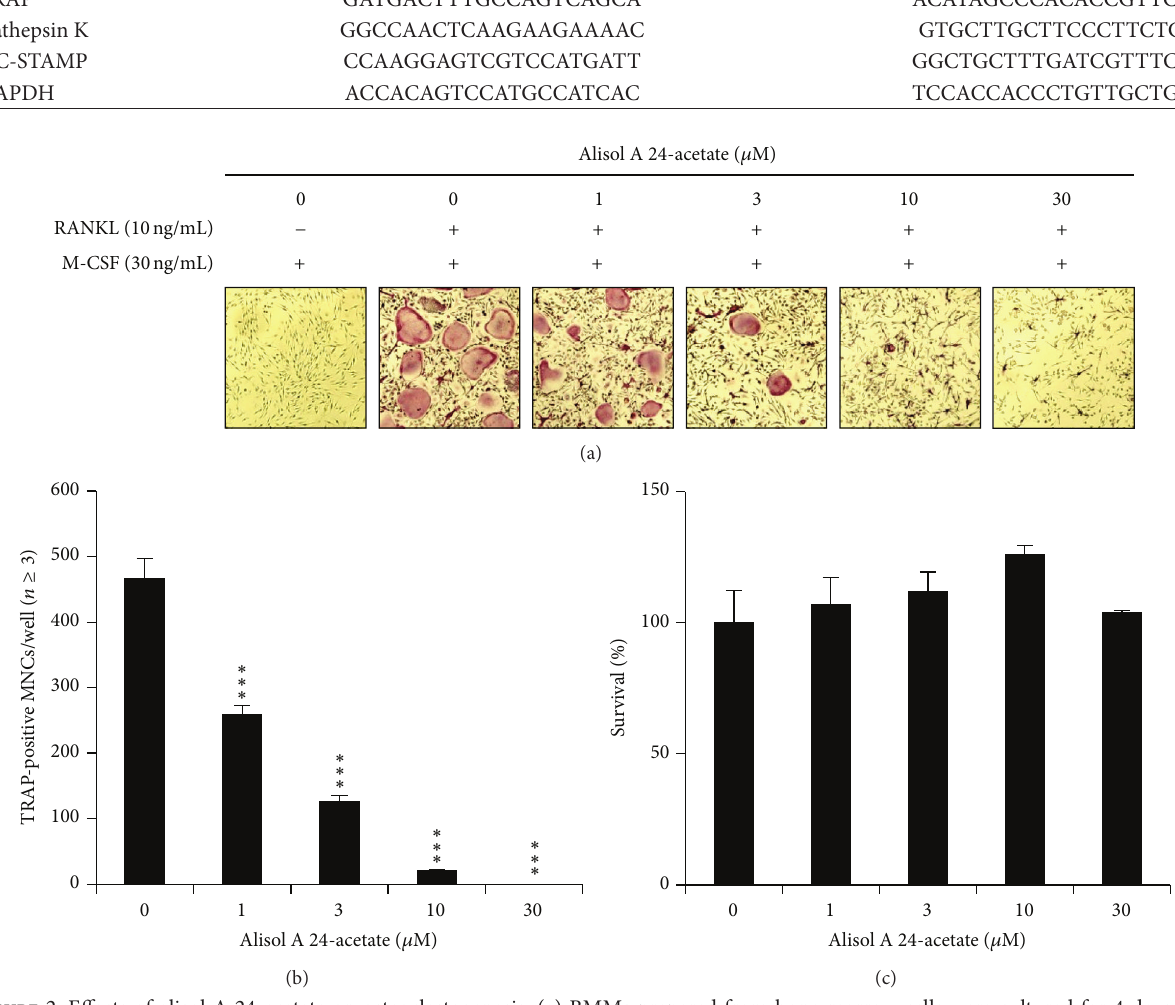
Figure 2: Effects of alisol A 24-acetate on osteoclastogenesis. (a) BMMs prepared from bone marrow cells were cultured for 4 days with RANKL (10ng/mL) and M-CSF (30 ng/mL) in the presence of the indicated concentrations of alisol A 24-acetate. Cells were fixed in 3.7% formalin, permeabilized in 0.1% Triton X-100, and stained for TRAP, a marker enzyme of osteoclasts. (b) TRAP-positive multinuclear cells with three or more nuclei were counted as osteoclasts. ∗∗ 𝑃 < 0.01 ; ∗∗∗ 𝑃 < 0.001 ( 𝑛 = 3 ). (c) Effect of alisol A 24-acetate on the viability on BMMs was evaluated by CCK-8